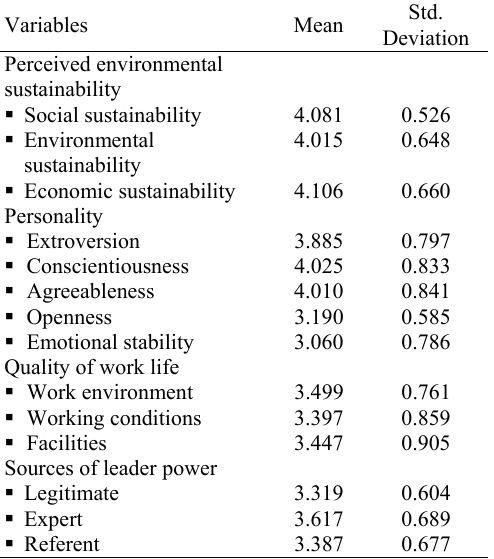
Table 2 : Descriptive analyses of variables Table 2: Descriptive analyses of variables Variables